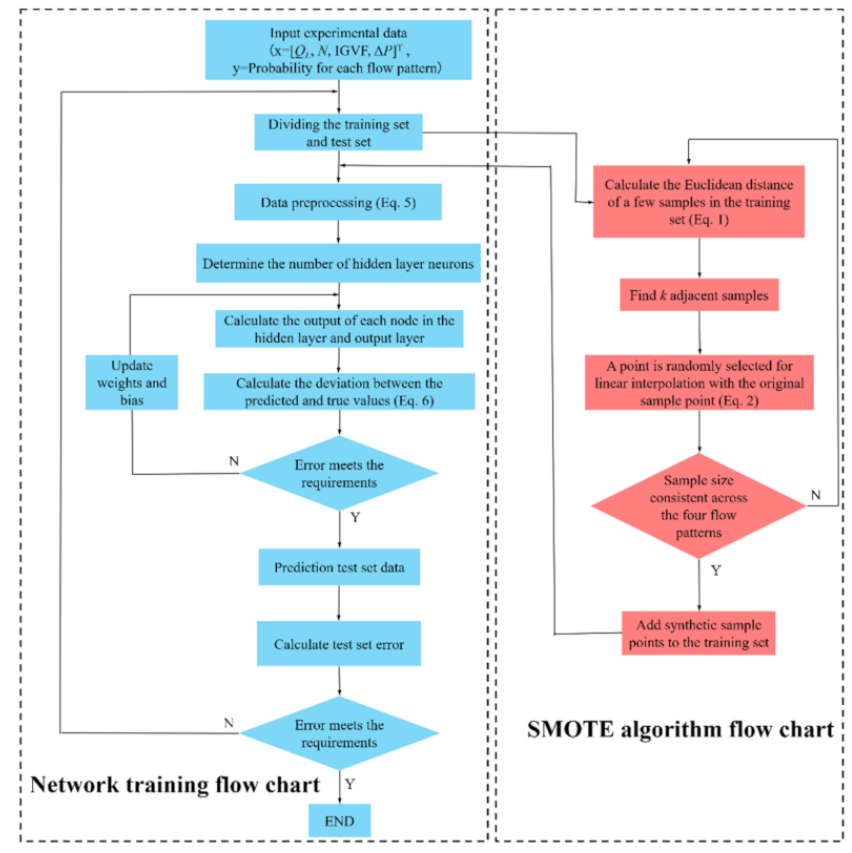
Figure 5. Model training flow